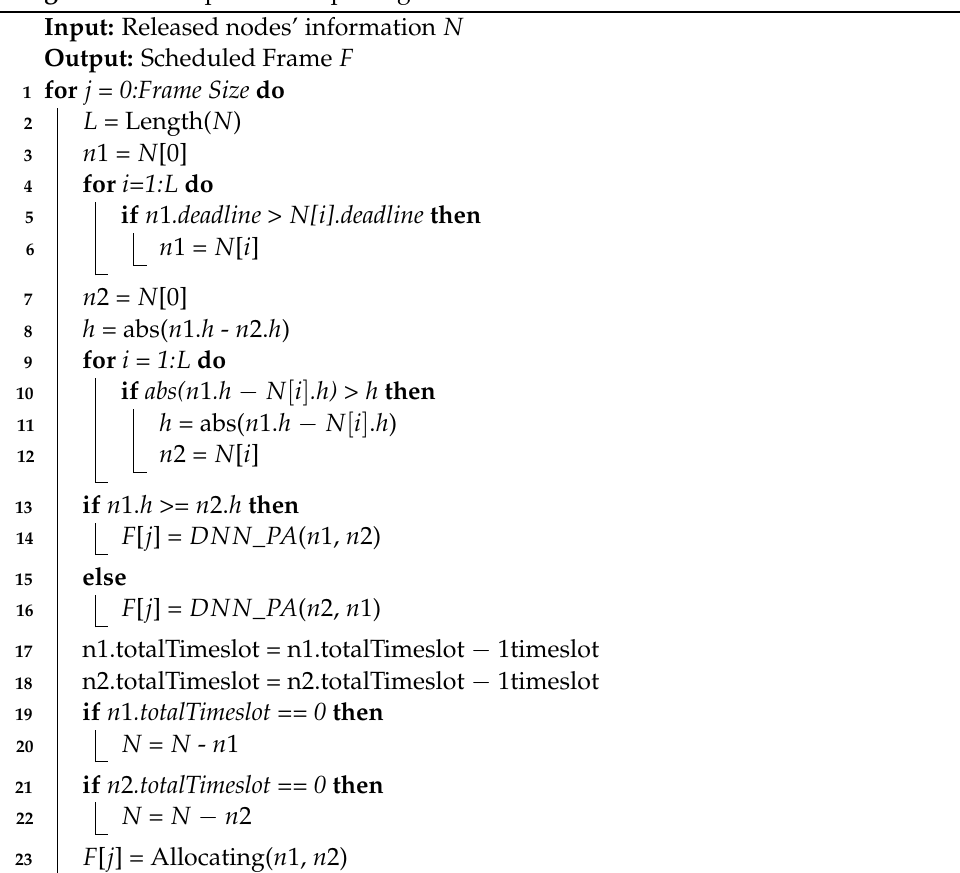
Algorithm 1: Proposed user pairing